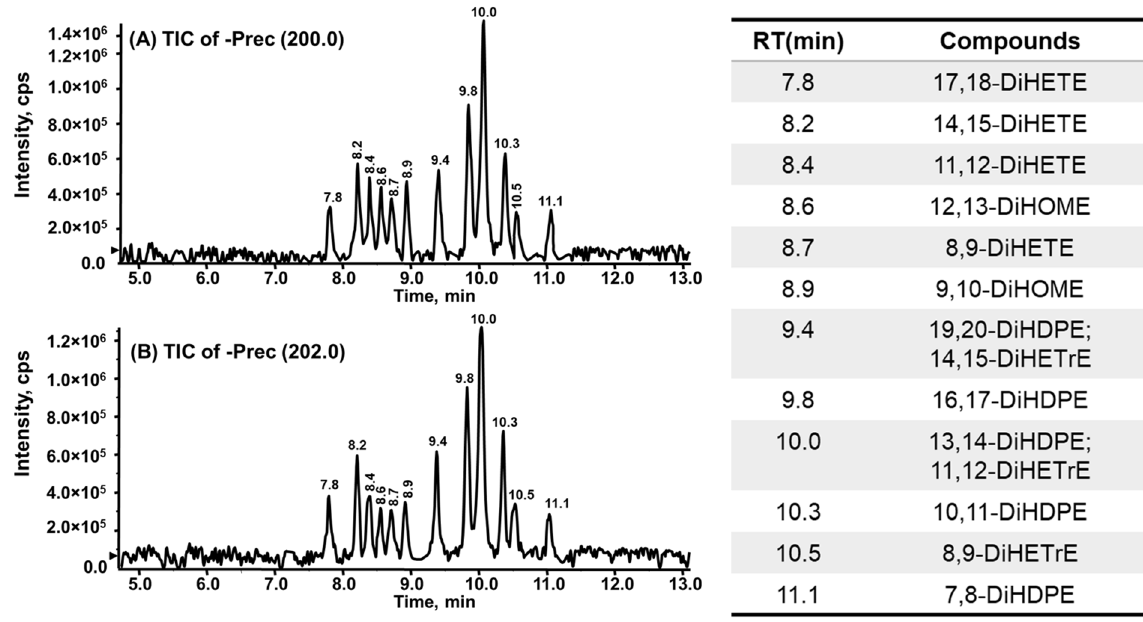
Figure 6. Identification of vicinal diols formed from human sEH hydration of a mixture of EpFAs, which presented in both precursor scan of m/z 200 ( A ) and 202 ( B